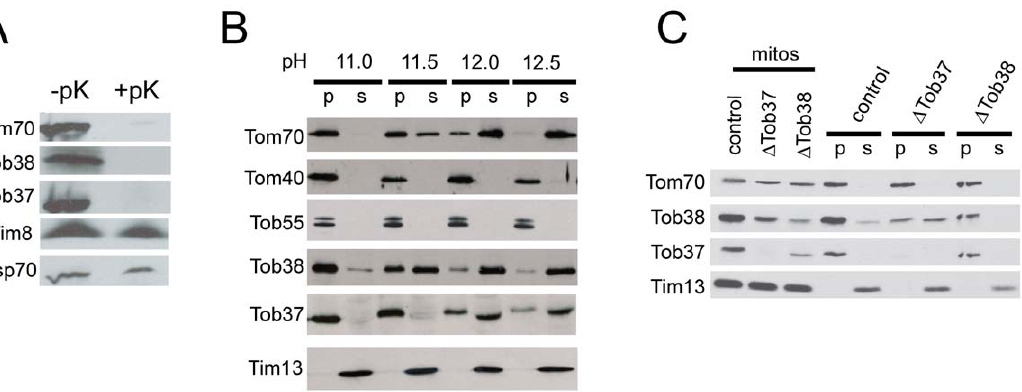
Figure 4. Topology of Tob37 and Tob38. (a) Mitochondria isolated from wild type cells (strain 76-26) were treated with proteinase K ( + pK) as in Figure 2C or not (-pK). Mitochondria were washed and subjected to SDS-PAGE. The gel was blotted to nitrocellulose and examined by immunodecoration with the antibodies indicated on the left. (b) Mitochondria from the control strain (76-26) were subjected to extraction with 0.1 M sodium carbonate at the pHs indicated at the top of the panel. Following the treatment, membrane sheets were pelleted and supernatants were subjected to trichloroacetic acid precipitation. Membrane pellets (p) and supernatant precipitates (s) were subjected to SDS-PAGE. Proteins in the gel were transferred to nitrocellulose and the membrane was examined with the antibodies indicated on the left. (c) As in panel B except extractions were done at pH 11.0 from control (HP1), D Tob37, and D Tob38 strains grown in the presence of histidine and fpa. The three lanes on the left show the protein levels in whole mitochondria (mitos), while the six lanes on the right show the pellets and supernatants resulting from alkali